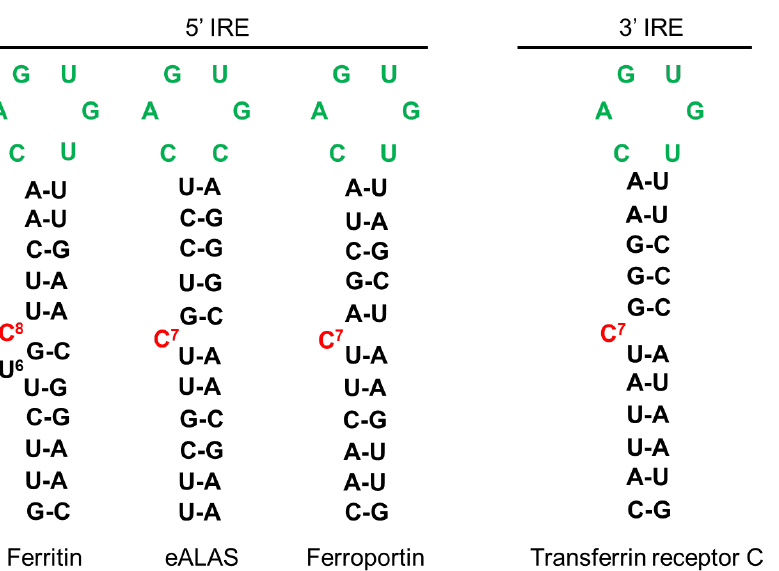
Table 4. Location of predicted IRE in SFXN1 splicing variants.